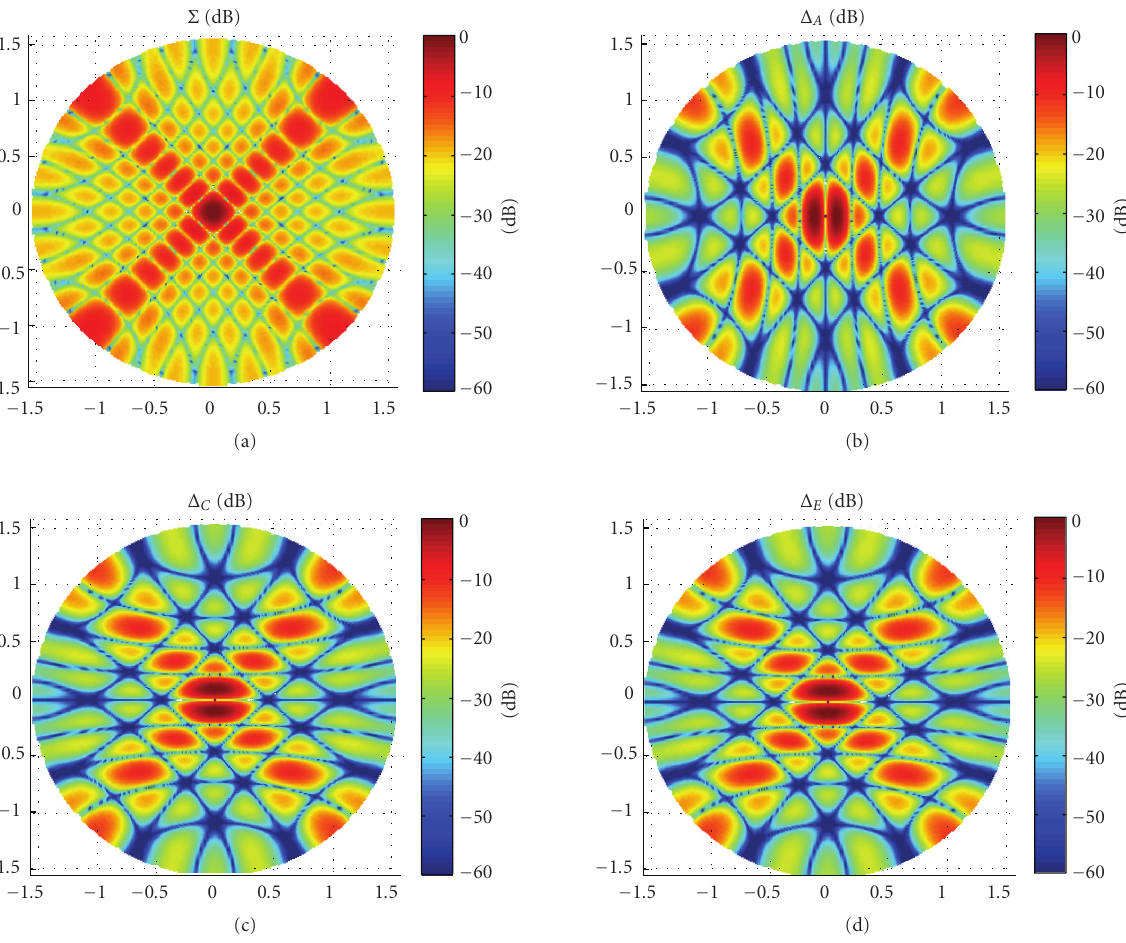
Figure 6: Patterns crossfeed monopulse. Patterns are given in a polar reference where the spherical angles ( θ , φ ) are mapped onto ( ρ , φ ) coordinates. It is very evident the vertical line of nulls in the azimuthal di ff erence pattern and the horizontal line of nulls in the elevation di ff erence pattern. The cross-di ff erence pattern presents two lines of nulls at ± 45 ◦